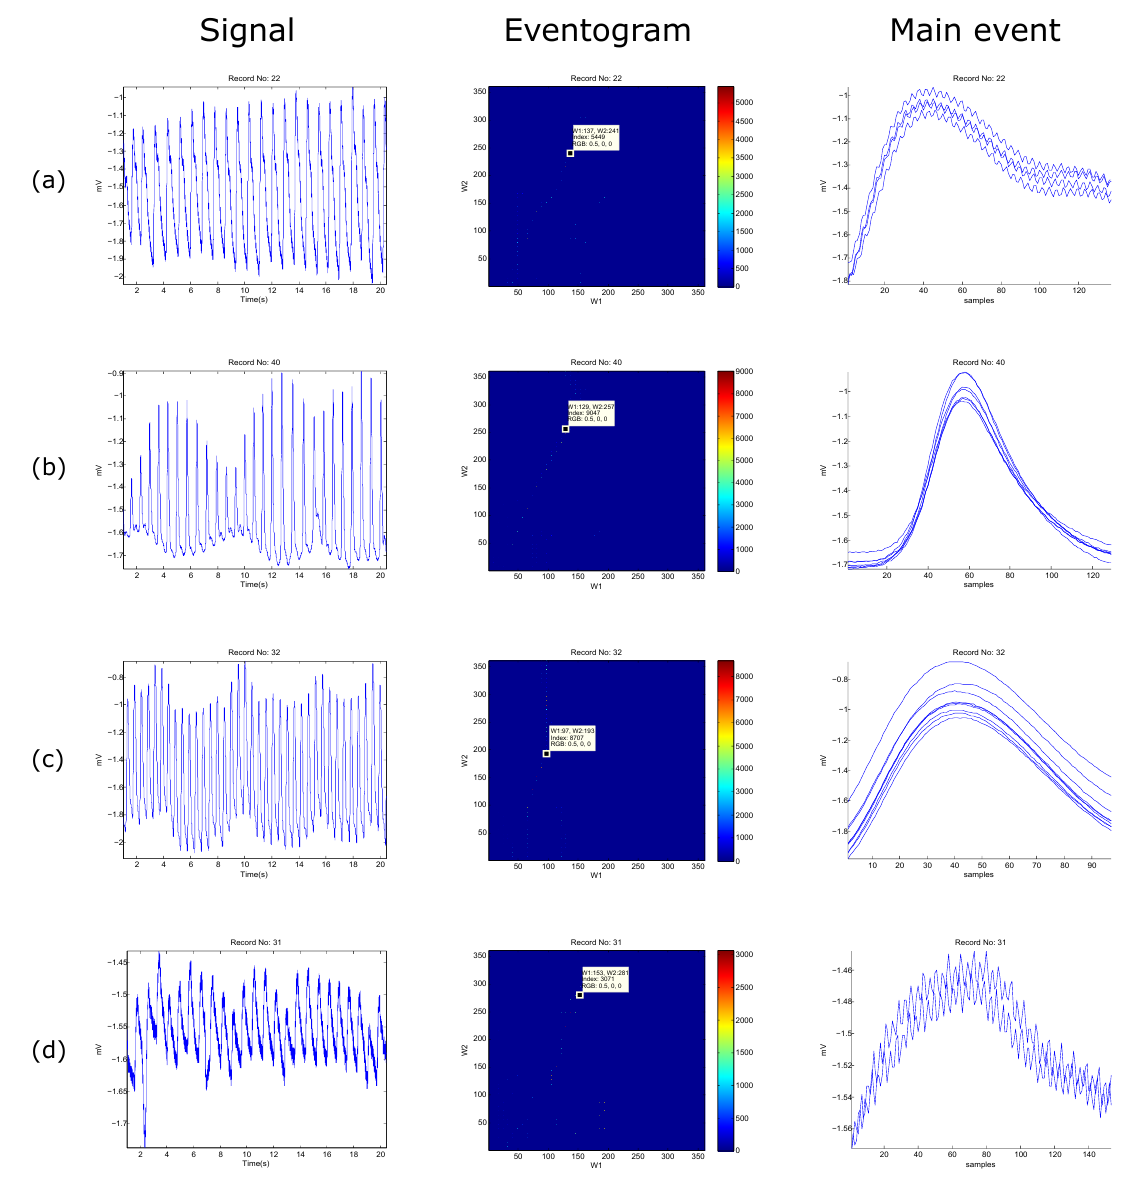
Figure 9. Examples of eventogram output using PPG signals. ( a ) PPG waveforms with Salient dicrotic notch; ( b ) PPG waveforms with a nonsalient dicrotic notch; ( c ) PPG signal measured after simulated heat stress; and ( d ) noisy PPG signal. The red color indicates strong dominance of a main event while the blue color indicates non-existence of a main event. The eventogram is stored as a two-dimensional ( W 1 -by- W 2 ) array of integers in the range [1, length(colormap)]; colormap is a W 1 -by-3 matrix of real numbers between 0.0 and 1.0. The eventogram returns the index value in terms of W 1 and W 2 for the most dominant event that is associated with the red color or RGB (0.5,0,0).